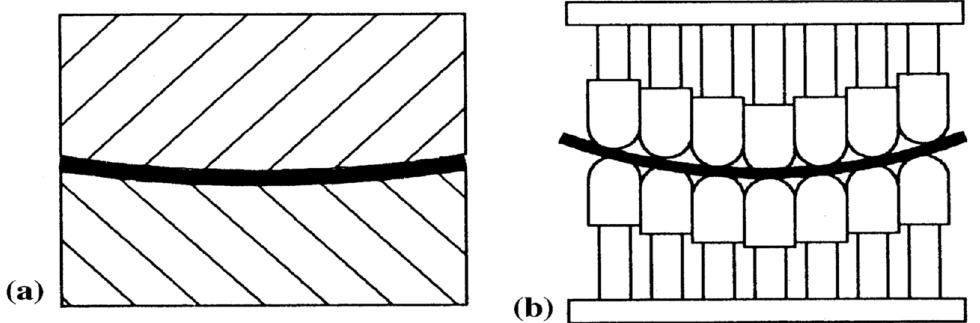
Fig. 1. comparison of multipoint forming: (a) forming die; (b) multipoint forming process. [4]